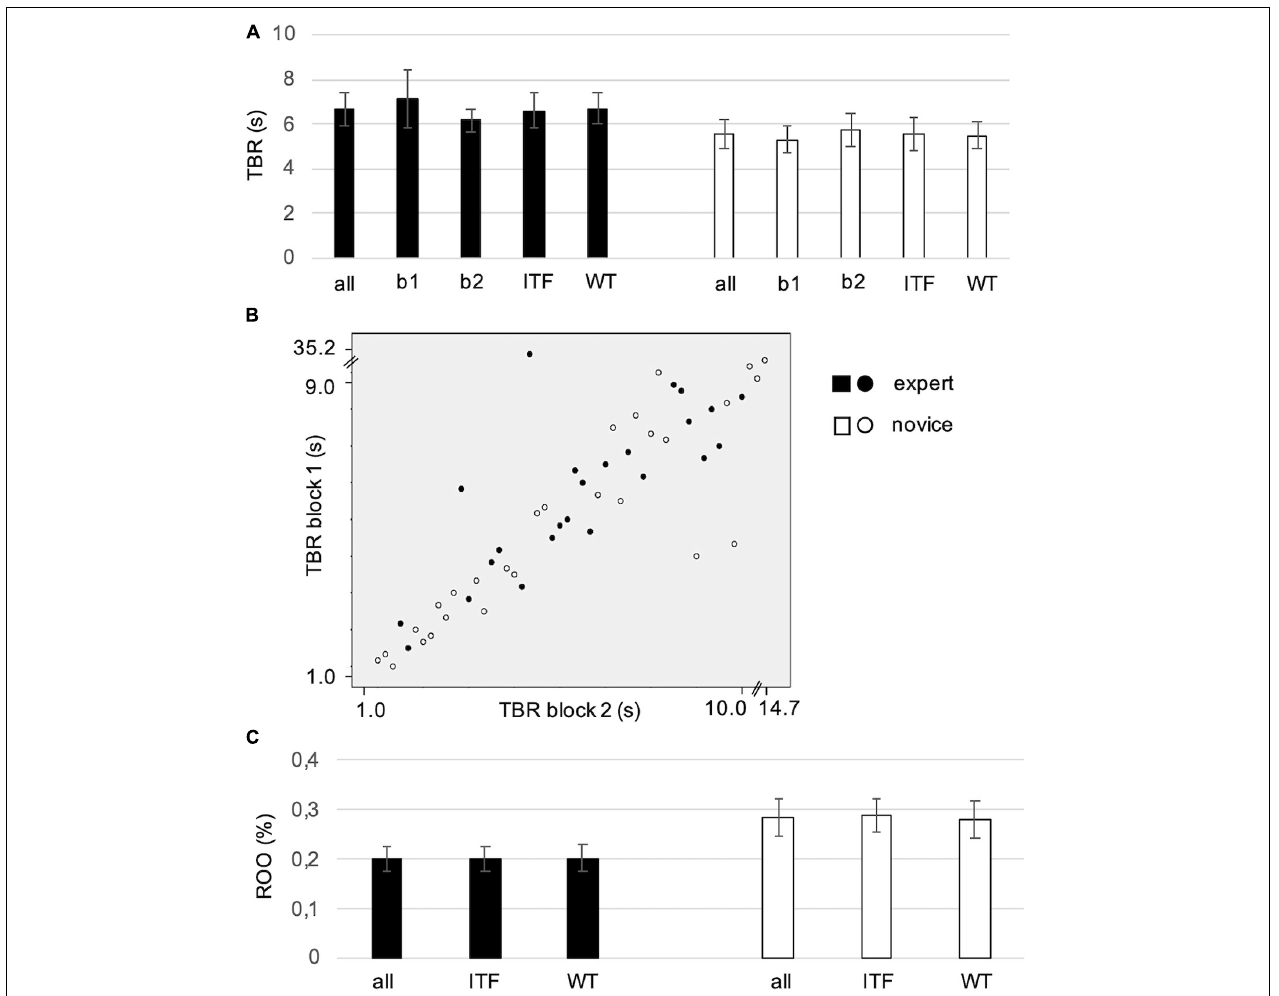
FIGURE 3 | (A) Average time between responses (TBR) in seconds (s) for experts and novices in experimental block 1 (b1) and block 2 (b2) and for two styles (ITF, WT). Error bars indicate SE. (B) Correlations of TBR in block 1 and block 2 for the two groups. Scales are adjusted to values and extreme values represent two outliers (expert in block 1: 35.2 s and novice in block 2: 14.7 s). (C) Average response overlap (ROO) expresses the rate of block 1 responses repeated in the same time window in block 2. Error bars indicate